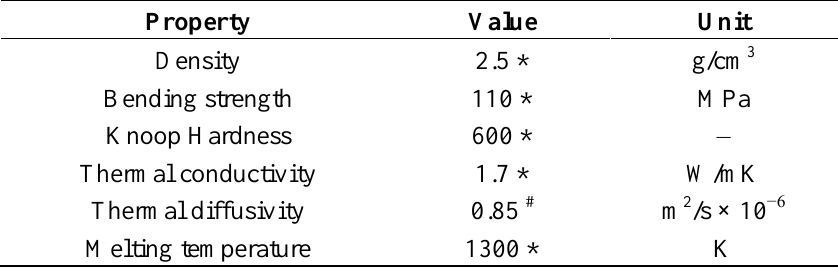
Table 1. Properties of the glass-ceramic substrate Ceran Suprema ®